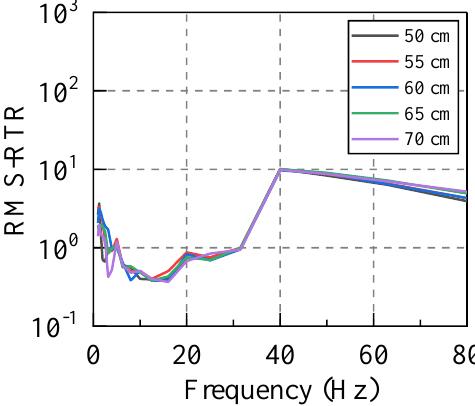
Figure 8. RMS − RTR. (Different excitation heights)